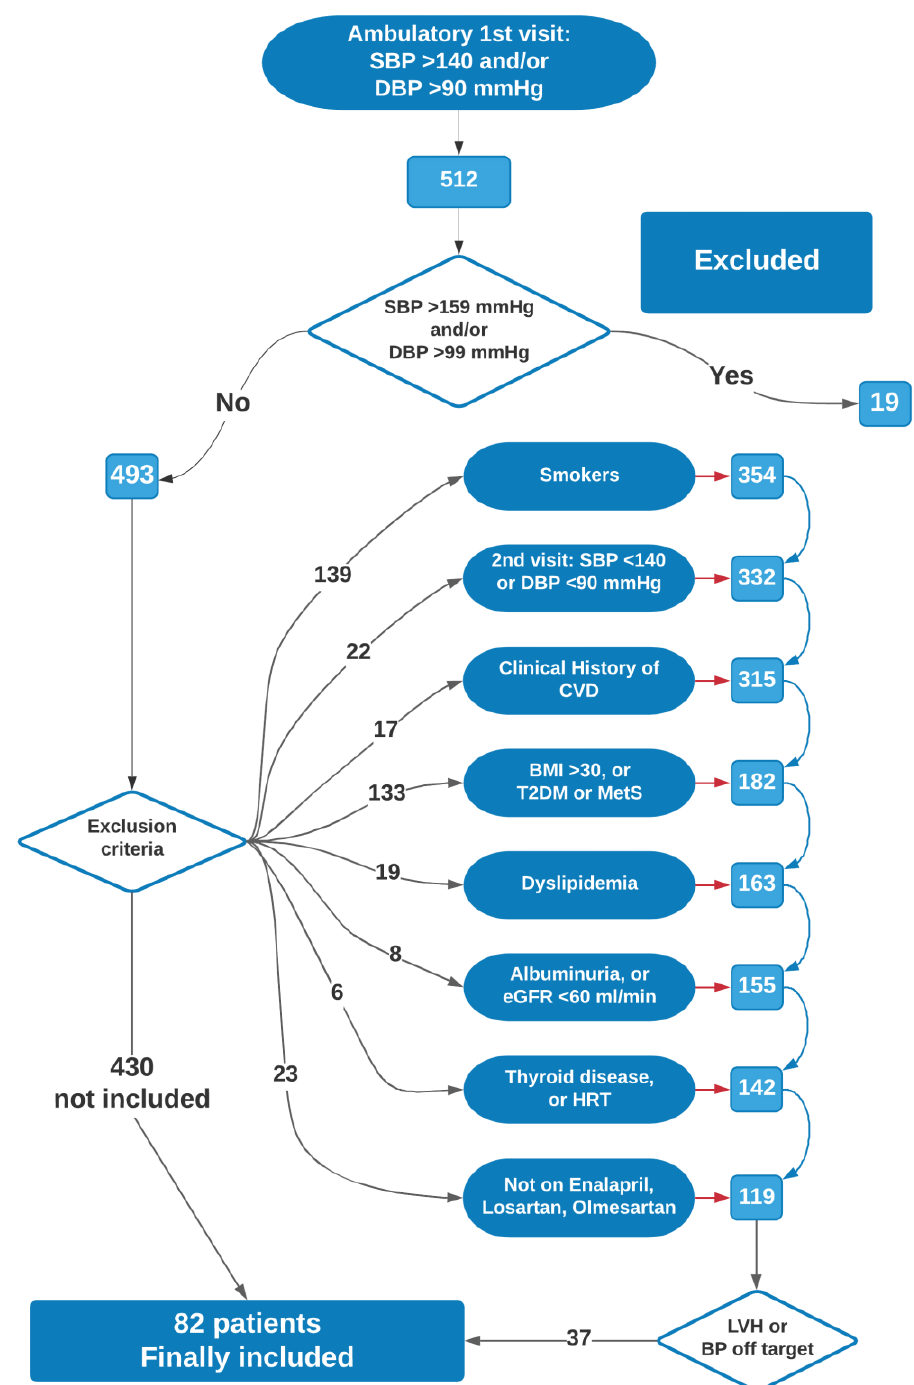
Figure 1. Selection flow of the final study population. Figure 1 represents the flow diagram for patient inclusion/exclusion path. (flow diagram was drawn by Lucidchart©, Lucid Software Inc., 2021; www.lucidchart.com; access date: 31 May